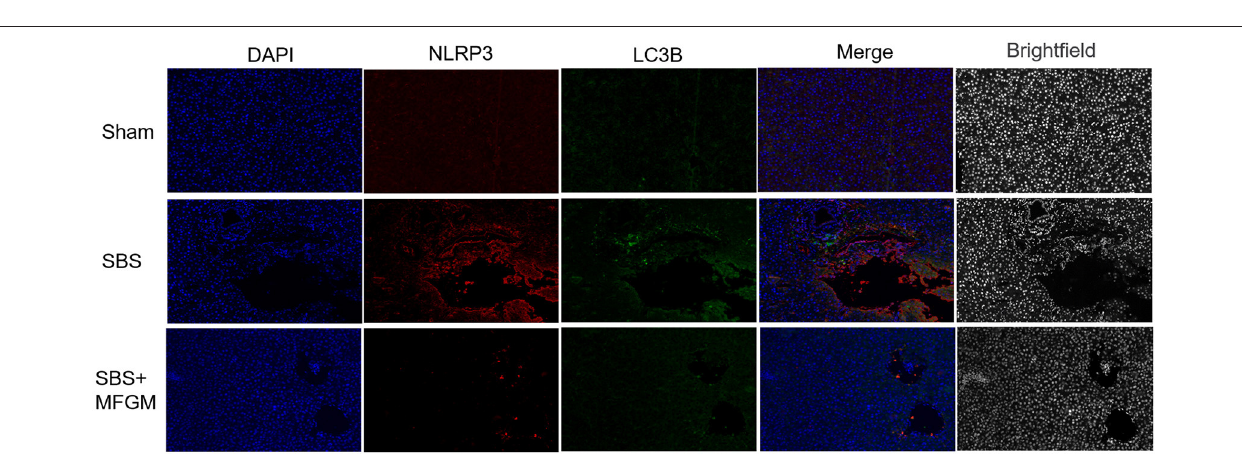
FIGURE 5 | Immunofluorescence staining of NLRP3 and LC3B in the liver. DAPI (blue), NLRP3 (red), LC3B (green), Scale bar: 100 µ m. NLRP3, nucleotide-binding oligomerization domain leucine-rich repeat and pyrin domain-containing protein 3; SBS, short bowel syndrome; LC3, microtubule-associated protein1 light chain 3; MFGM, milk fat globule membrane; SBS, short bowel